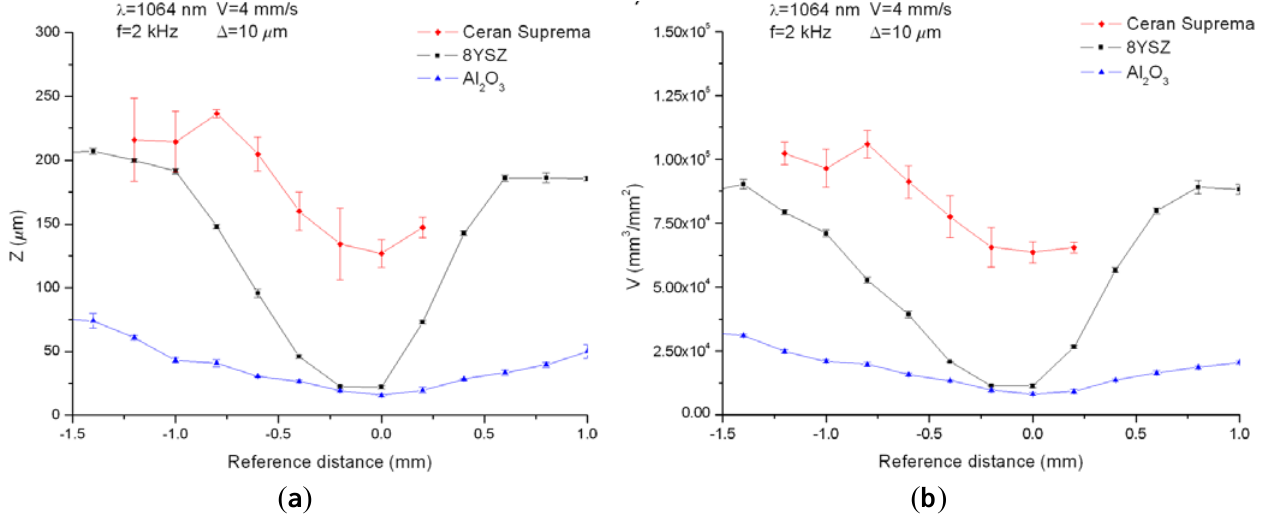
O and glass-ceramic 2 3